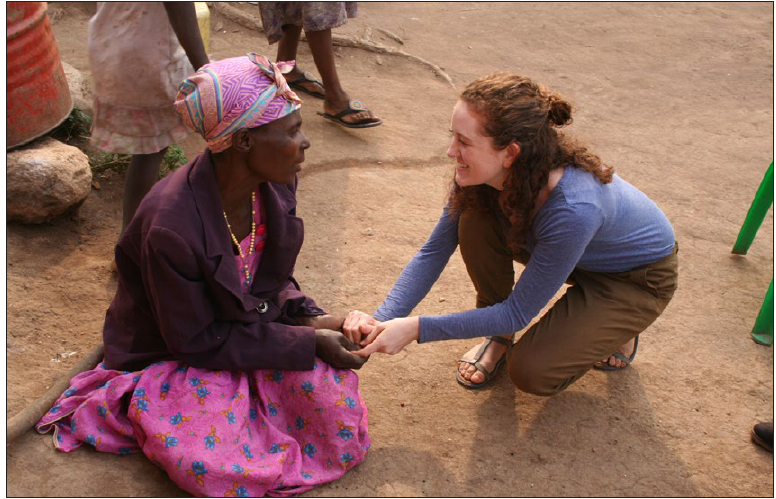
Figure 4: IoA PhD student Hannah Page conducting ethnoarchaeological research with a local potter in Uganda in 2017 (Photo Hannah